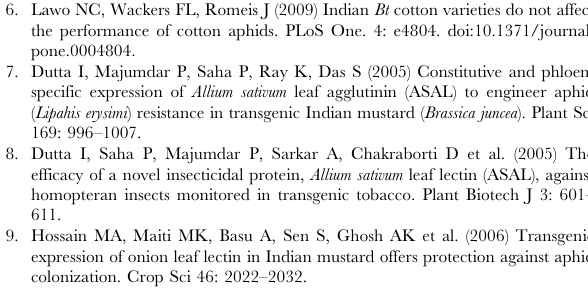
Table S1 Primer sequences of cDNA AFLP primers. Table S2 Primer combinations used in cDNA AFLP analysis. Table S3 Real time RT PCR primers. Table S4 Relative expression levels of the cDNA